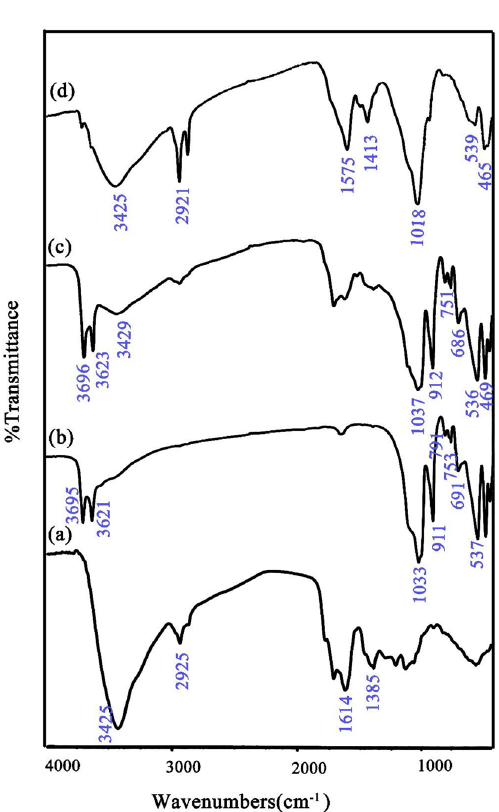
Figure 6. FT-IR spectra of (a) pristine S, N-GQDs, (b) pristine HNTs, (c) S, N-GQDs/HNTs and (d) CoFe 2 O 4 /S, N-GQDs/HNTs